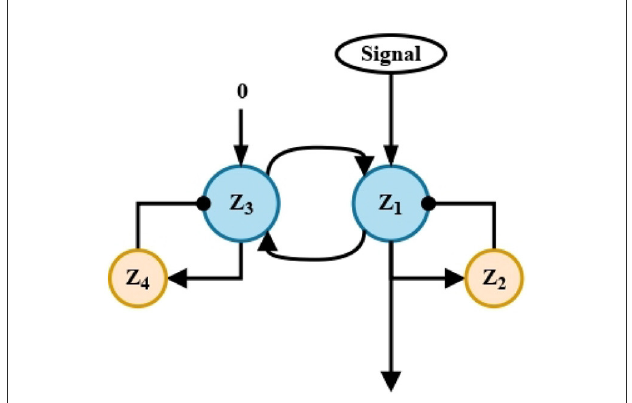
FIGURE2 Short-term memory circuit. Recurrent excitation. Two circuits similar to that shown above, process the signals A r and A l , respectively. The four processing units shown correspond to the units named in Equations (3)–(6) y